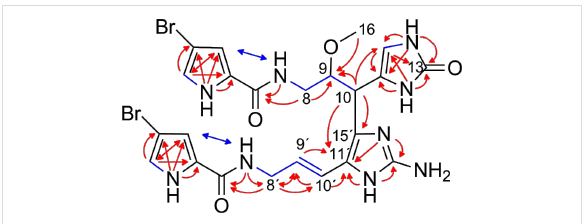
Figure 4: Selected 1 H, 1 H-COSY (blue bonds), 1 H, 1 H-NOESY (blue arrows), and 1 H, 13 C-HMBC (red arrows) correlations for citrinamine C ( 3 ).